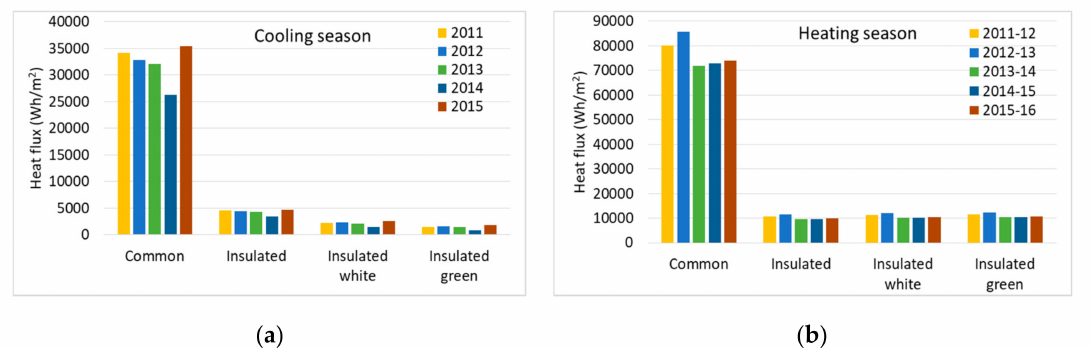
Figure 12. Comparison of heat fluxes (Wh / m 2 ) between common roof, insulated common roof, insulated high-reflectance roof, and insulated green roof: ( a ) Cooling season; ( b ) heating